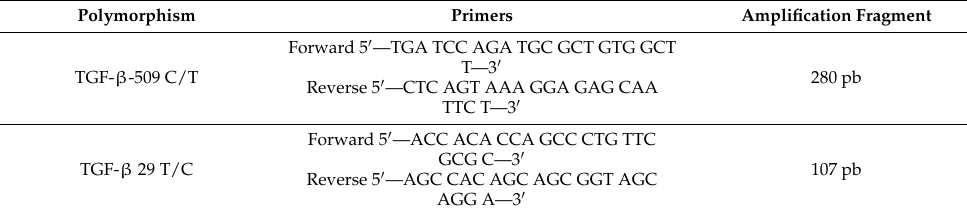
Table 10. Primers and amplification fragments for TGF- β polymorphisms.